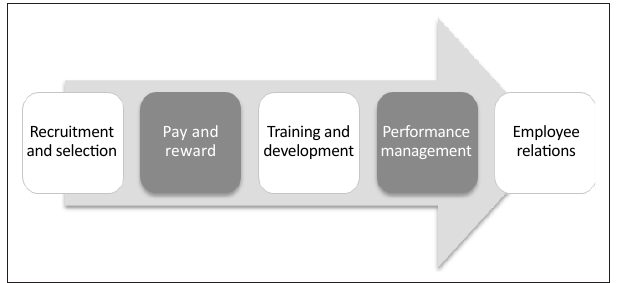
FIGURE 1: Human resource value